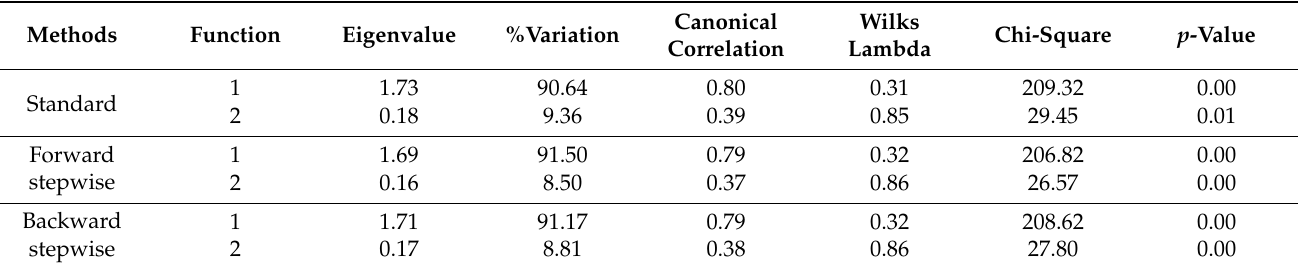
Table 1. Coefficients of functions discriminant to the temporal